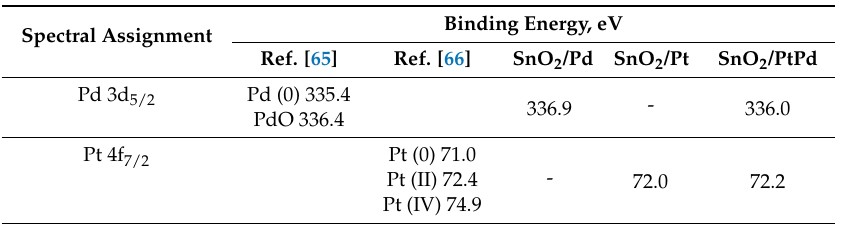
Table 2. Pd 3d 5/2 and Pt 4f 7/2 XP spectral assignments.